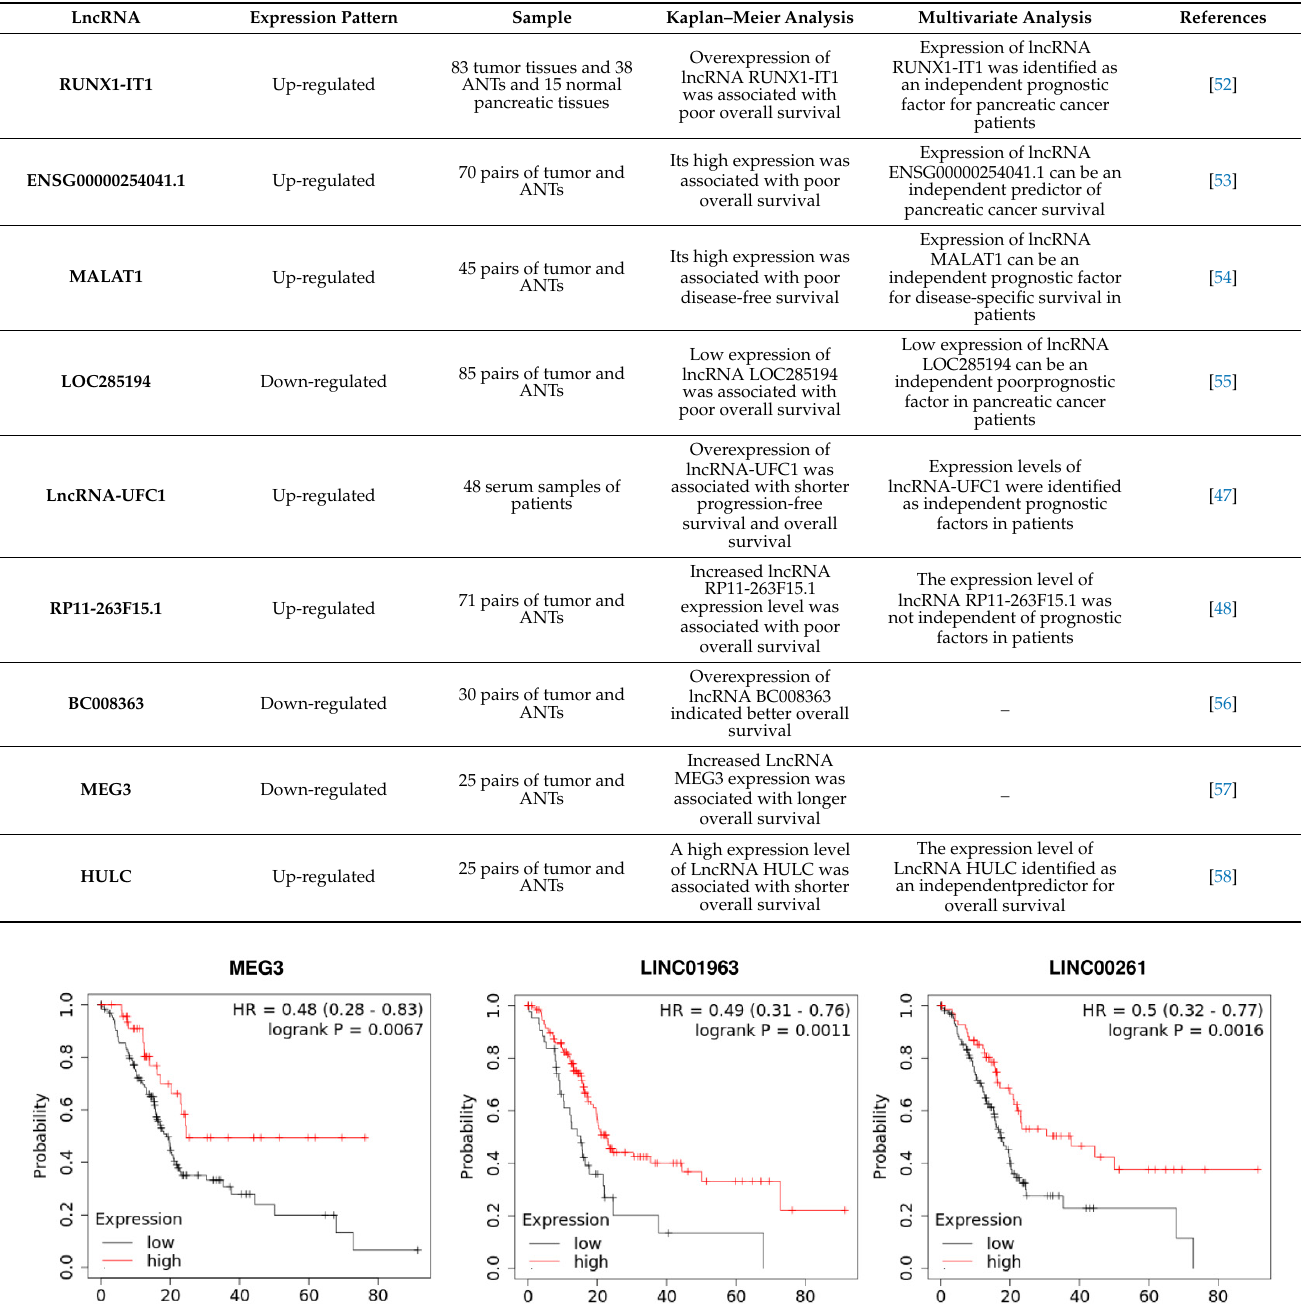
Table 4. Prognostic role of lncRNAs in pancreatic cancer (ANT: adjacent non-cancerous tissue).